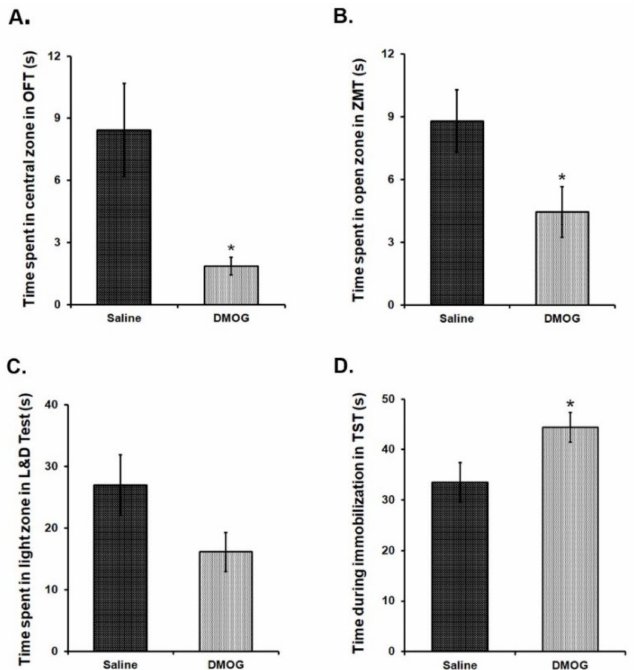
Figure 6. 10 days chronic DMOG administration induced anxiety and depression-like phenotype in mice without any stress exposure. DMOG administered mice display an anxiety-like phenotype as they spend significantly lesser time in the central zone of the open field box ( A ), open zone of the zero maze ( B ), and light zone of the light and dark box ( C ) as compared to the vehicle (Saline) injected mice. ( D ) DMOG-injected mice spend significantly more time being immobilized in the tail suspension test, suggesting a depression-like phenotype. ( n = 9–11 / group). * p <